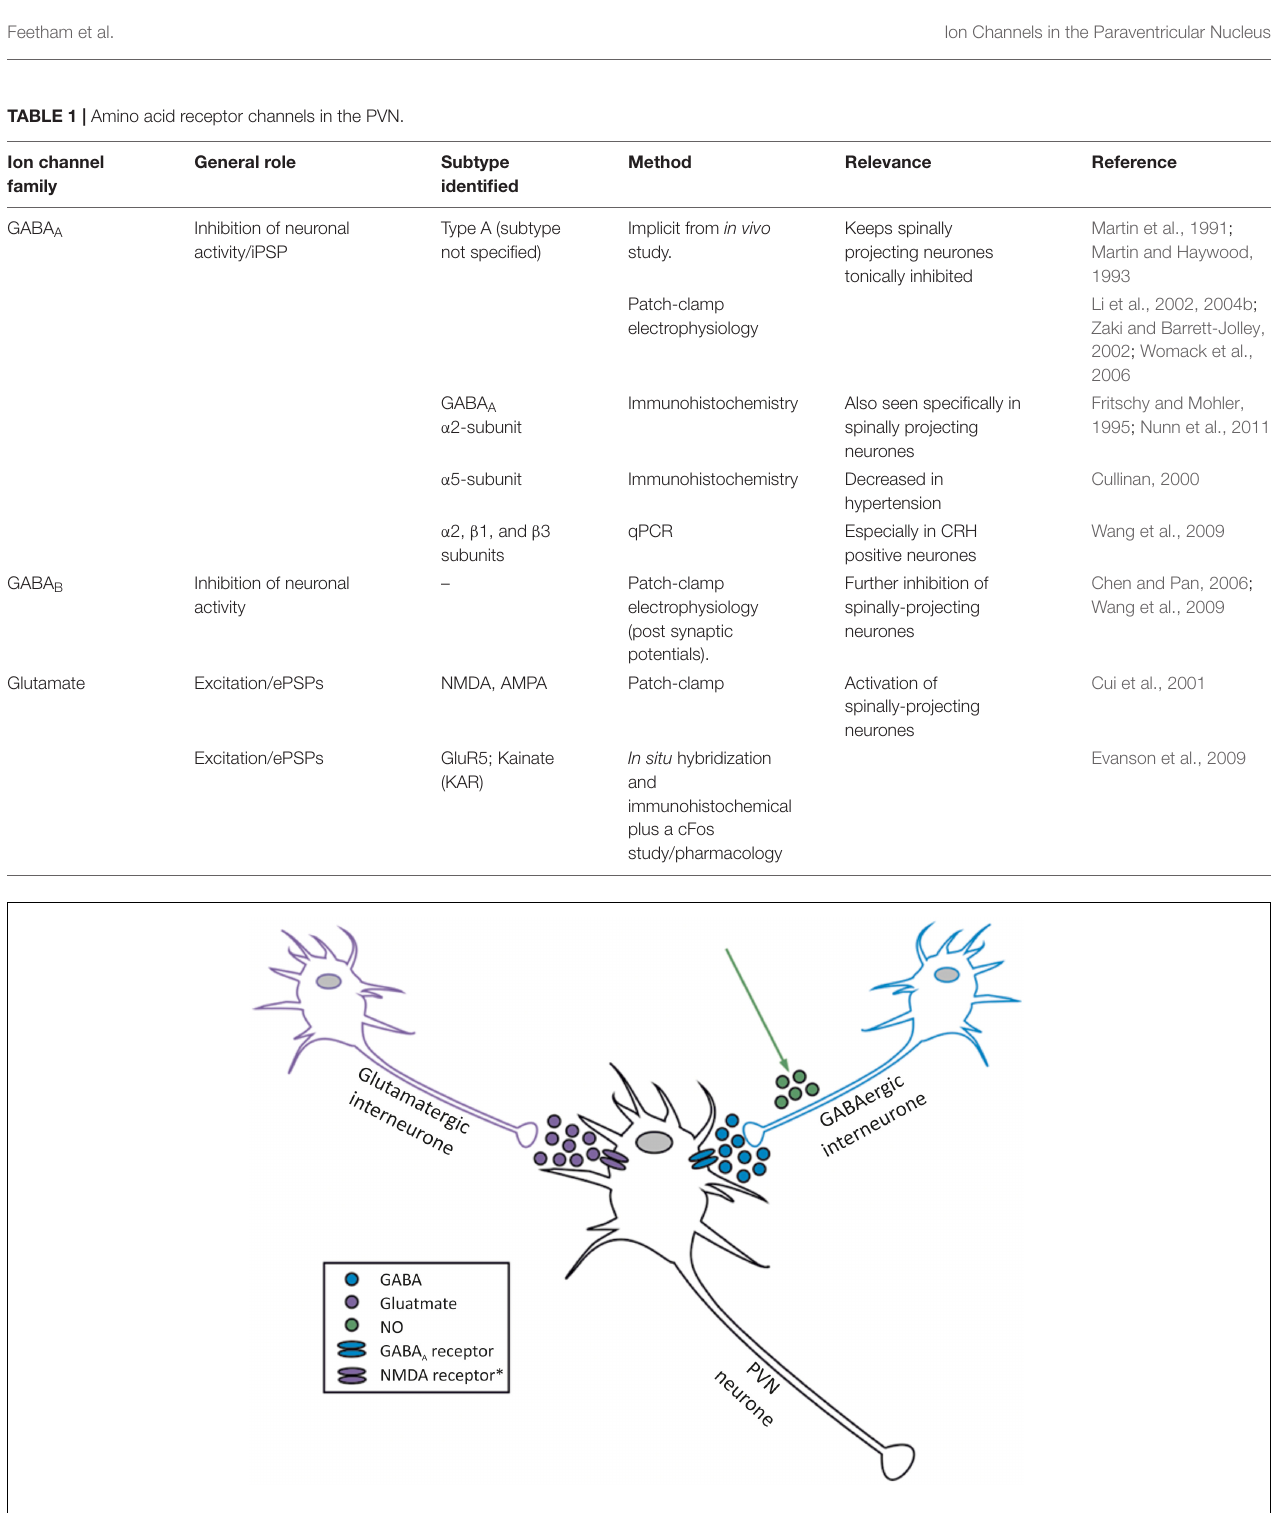
seven subfamilies, TRPC (canonical; seven members), TRPV (vanilloid; six members), TRPA (ankyrin; 1 member), TRPM (melastatin; eight members), TRPML (mucolipin; 1